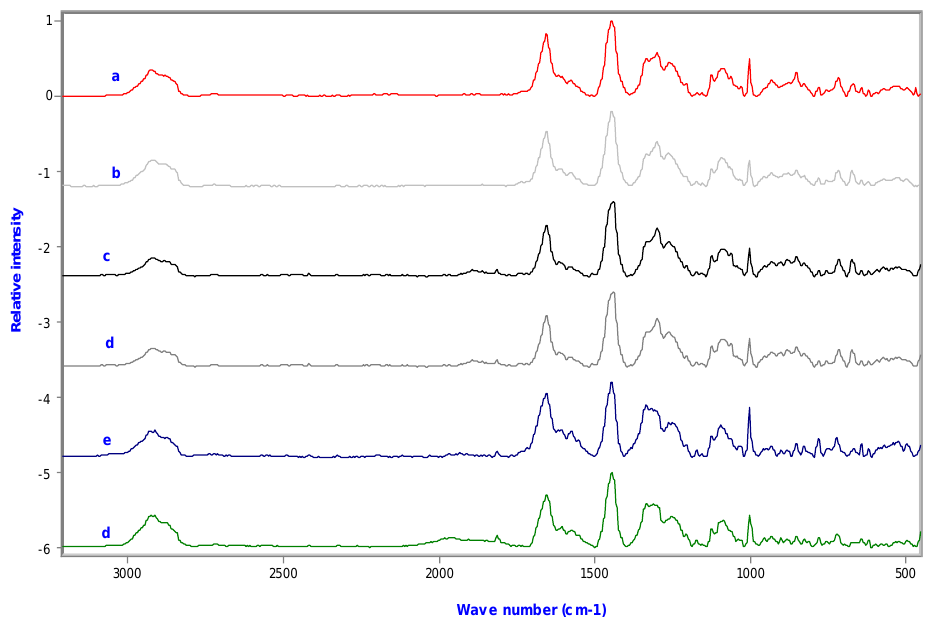
Figure 4. Comparison of the RM spectra (500-3500 cm − 1 ) of Caco-2 cells incubated for 24 h with (100 µ g / mL) of ( a ) 24, ( b ) 48 and ( c ) 72 h UV-radiated ML or ( d ) 24, ( e ) 48 and ( f ) 72 h UV-radiated fish oil.